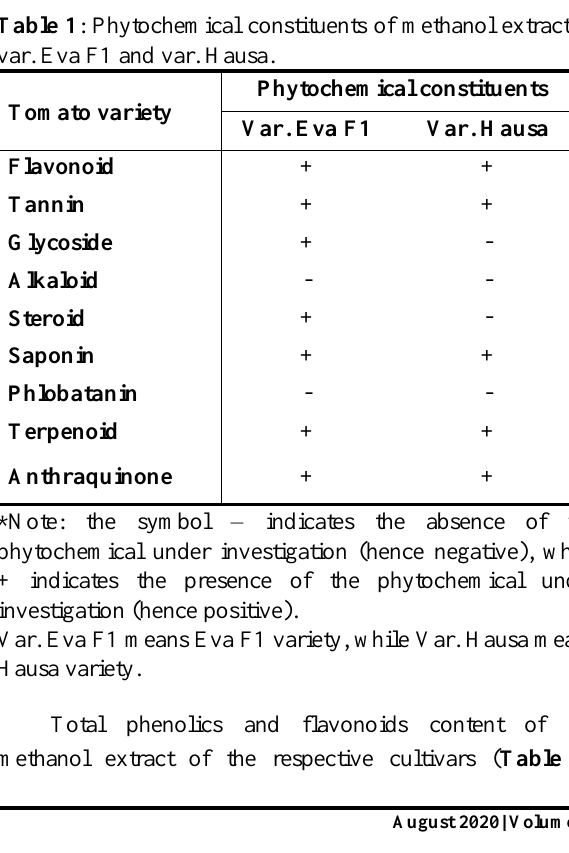
Table 1 : Phytochemical constituents of methanol extract of var. Eva F1 and var. Hausa.